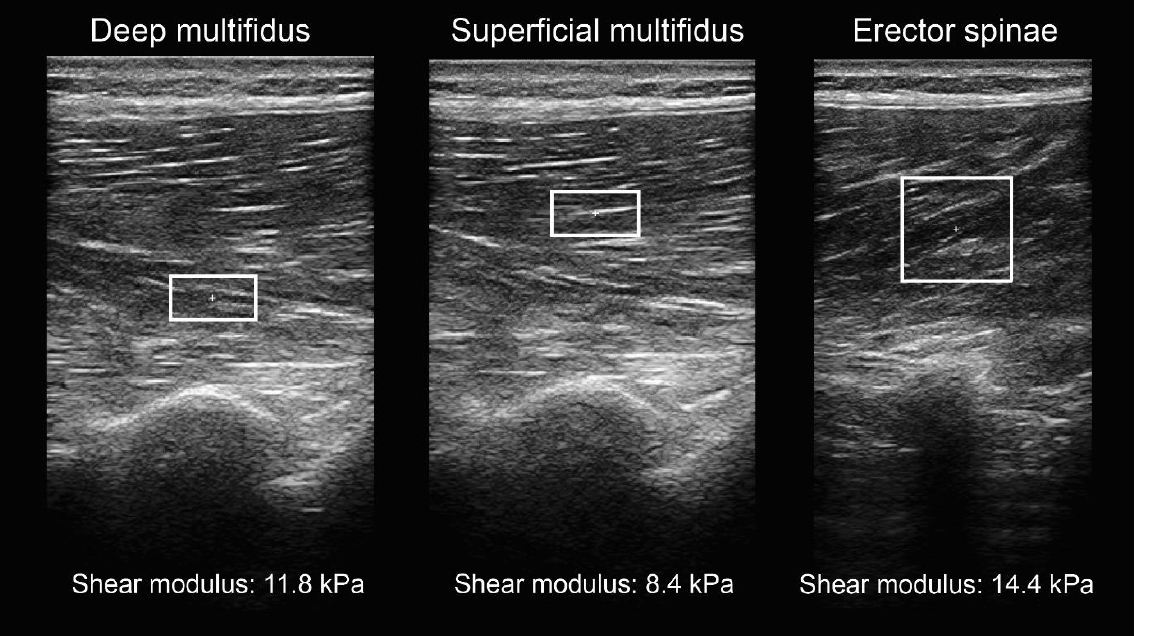
Figure 4. Snapshots from shear modulus measurements at rest. The rectangles represent the region of interest.